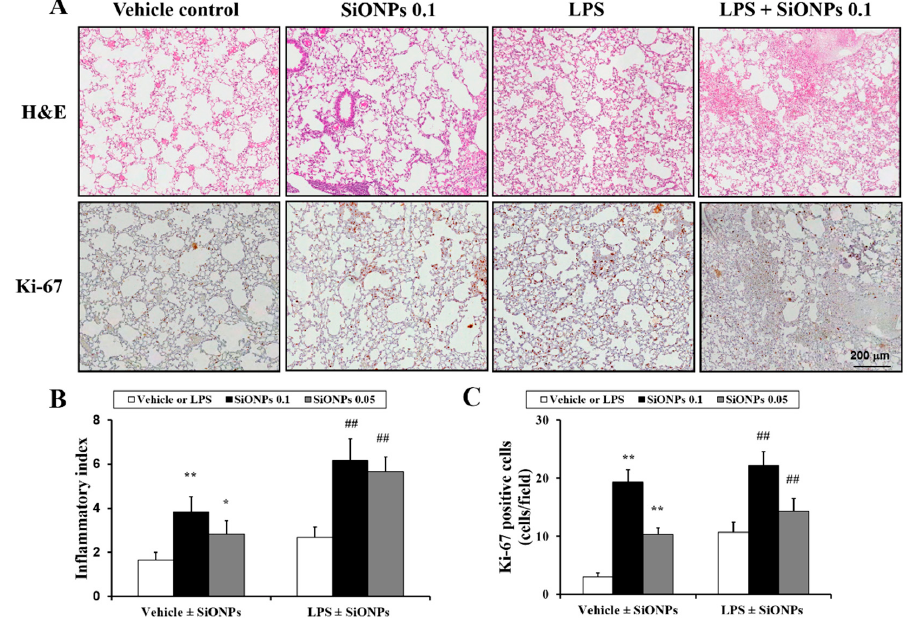
Figure 4. Effect of SiONPs exposure on inflammatory responses in lung tissues of each group. ( A ) Representative images of inflammatory responses in lung tissue of each group. ( B ) Quantitative analysis of inflammatory responses in lung tissue of each group. ( C ) Quantitative analysis of Ki-67 expression in lung tissue of each group. Data represent the means ± SD ( n = 5 per group). * and p < 0.05 and ** p < 0.01 vs. vehicle control. ## p < 0.01 vs. LPS.